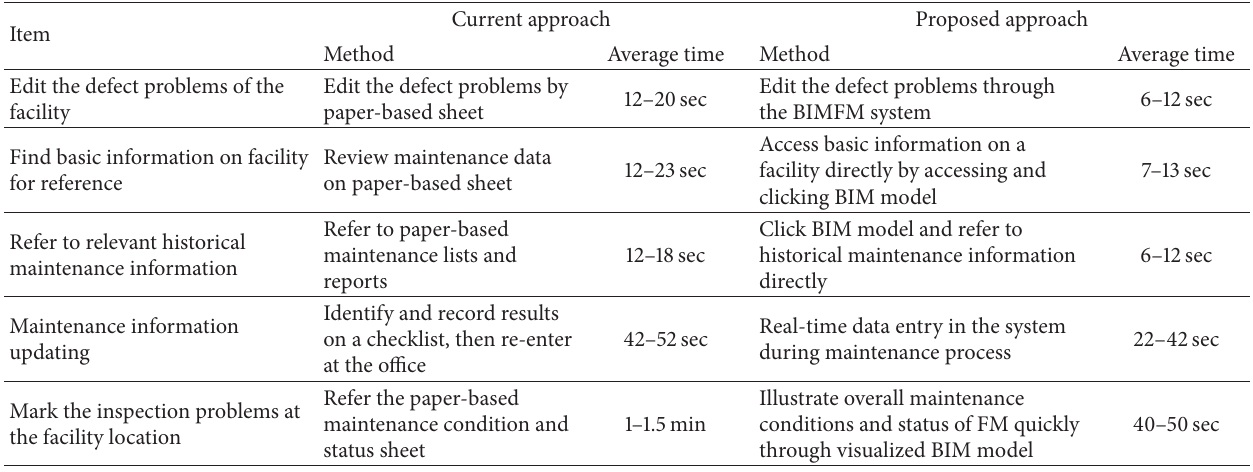
Table 2: Comparison of current approach and proposed system.